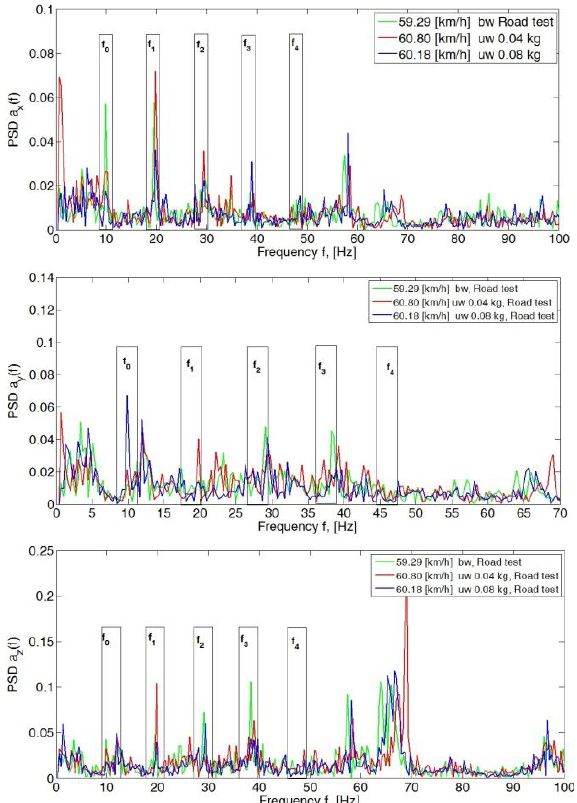
Figure 5. Power spectral density graph of the body acceleration signal for a speed of 60 km/h.